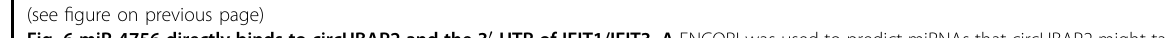
MHCC-97H and Huh-7 cells with or without CXCL11 treatment. miR-4756 was chosen for further experiments due to its downregulation in both HCC cell lines in response to CXCL11 stimulation. B MHCC-97H and Huh-7 were transfected with si-circUBAP2 and examined for the expression of